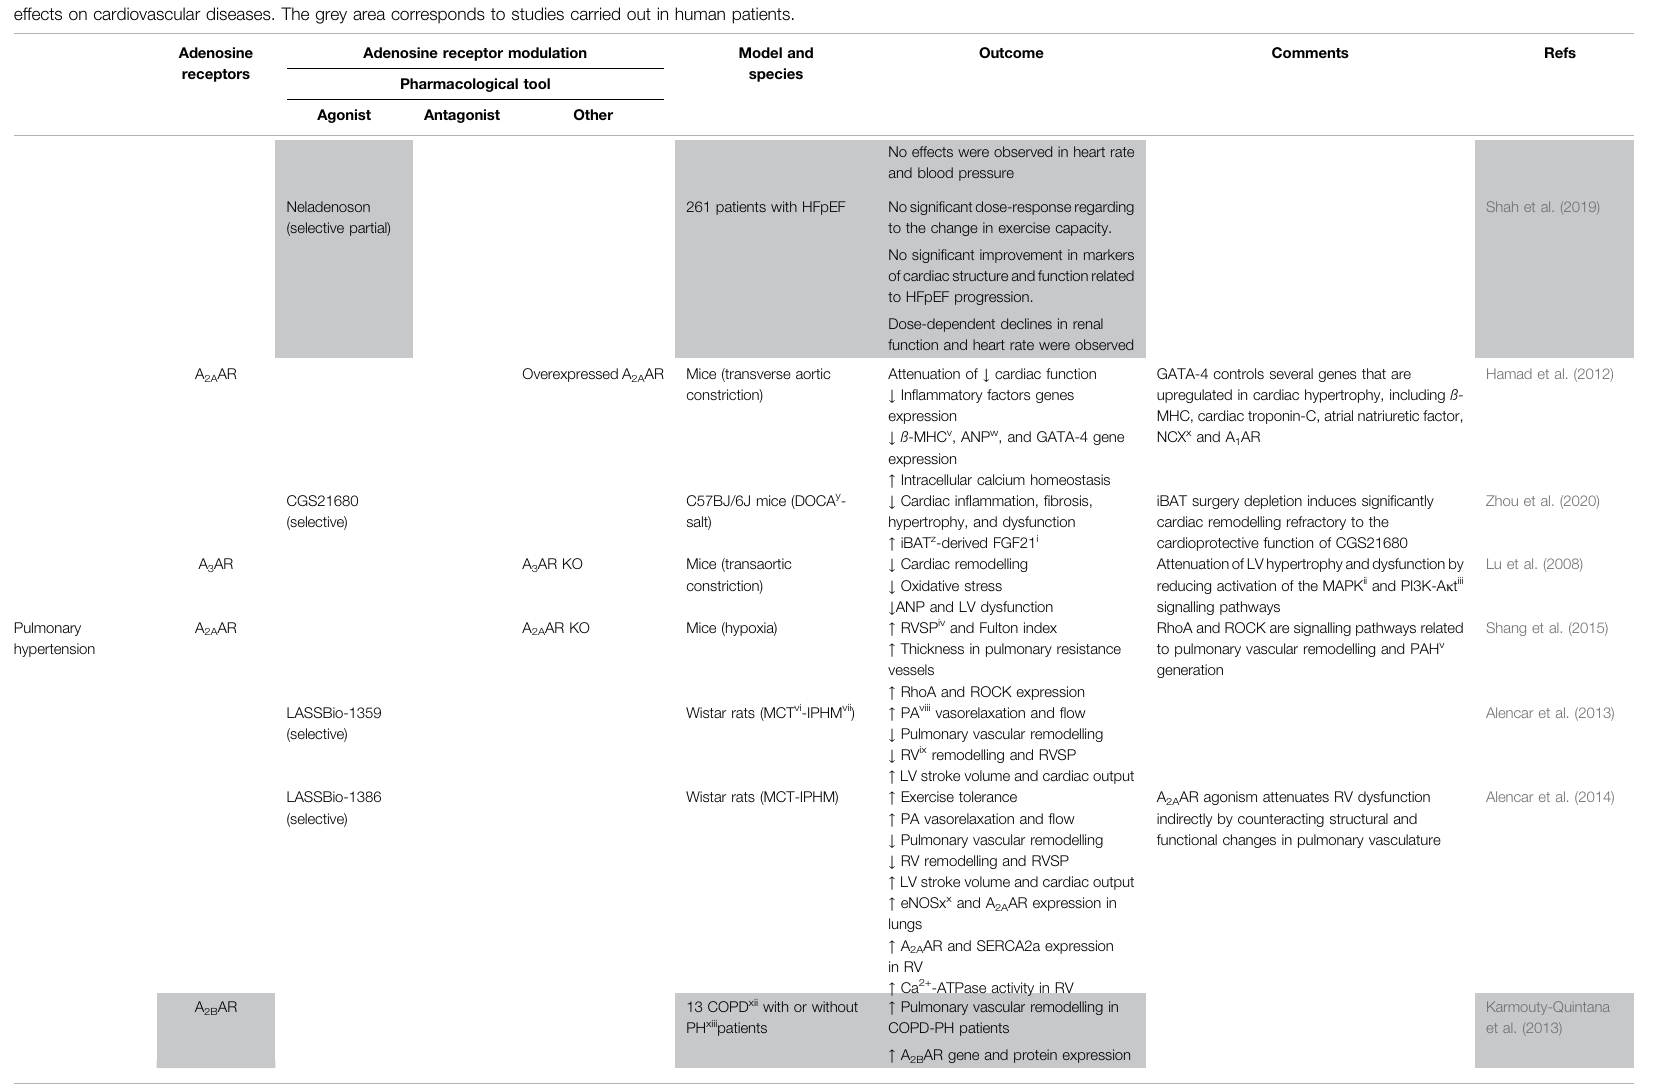
LV a , Left ventricle; AR b , Adenosine receptor; KO c , Knockout; AMP d , 5 ′ -adenosine monophosphate; mTOR e , Mechanistic target of rapamycin; ADK f , Adenosine kinase; CADO g , 2-chloroadenosine; BNP h , B-type natriuretic peptide; RGS i , Regulator of G protein signalling; CPA j , N6-cyclopentyladenosine; DPCPX k , 8-Cyclopentyl-1,3-dipropylxanthine; AngII l , Angiotensin II; IGF m , Insulin growth factor; CAP n , Capadesonon; HF o , Heart failure; MPTP p , Membrane permeability pores;SERCA q ,sarco/endoplasmicreticulumCa2+-ATPase;UCP r ,Uncouplingprotein; GLUT s ,Glucosetransportertype;HFrEF t ,Heartfailurewithreducedejectionfraction;HFpEF u ,Heartfailurewithpreservedejectionfraction; ß -MHC v , myosinheavychain-beta;ANP w ,Atrialnatriureticpeptide;NCX x ,Sodium-calciumexchanger;DOCA y ,Deoxycorticosteroneacetate;iBAT z ,interscapularbrownadiposetissue;FGF21 z ,Fibroblastgrowthfactor21;MAPK ii